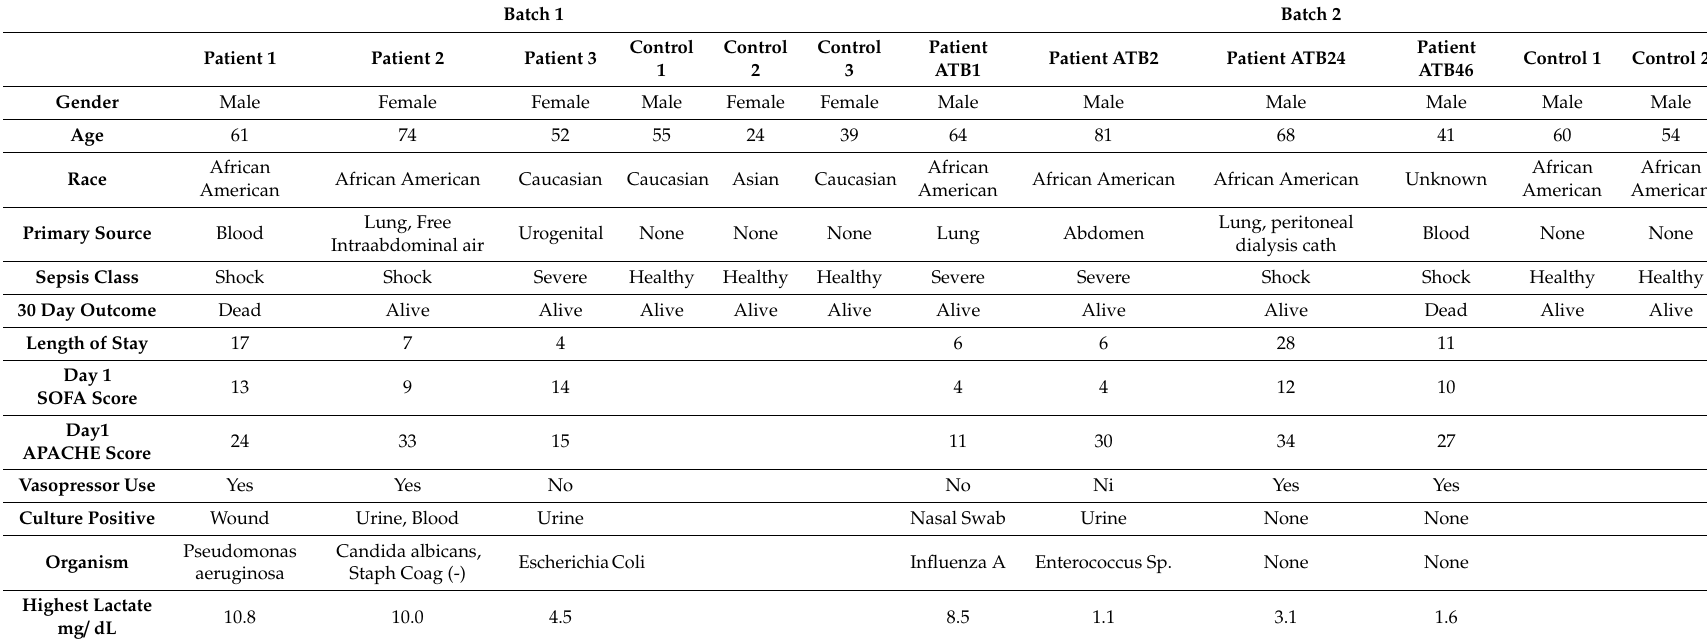
Table 1. Patient